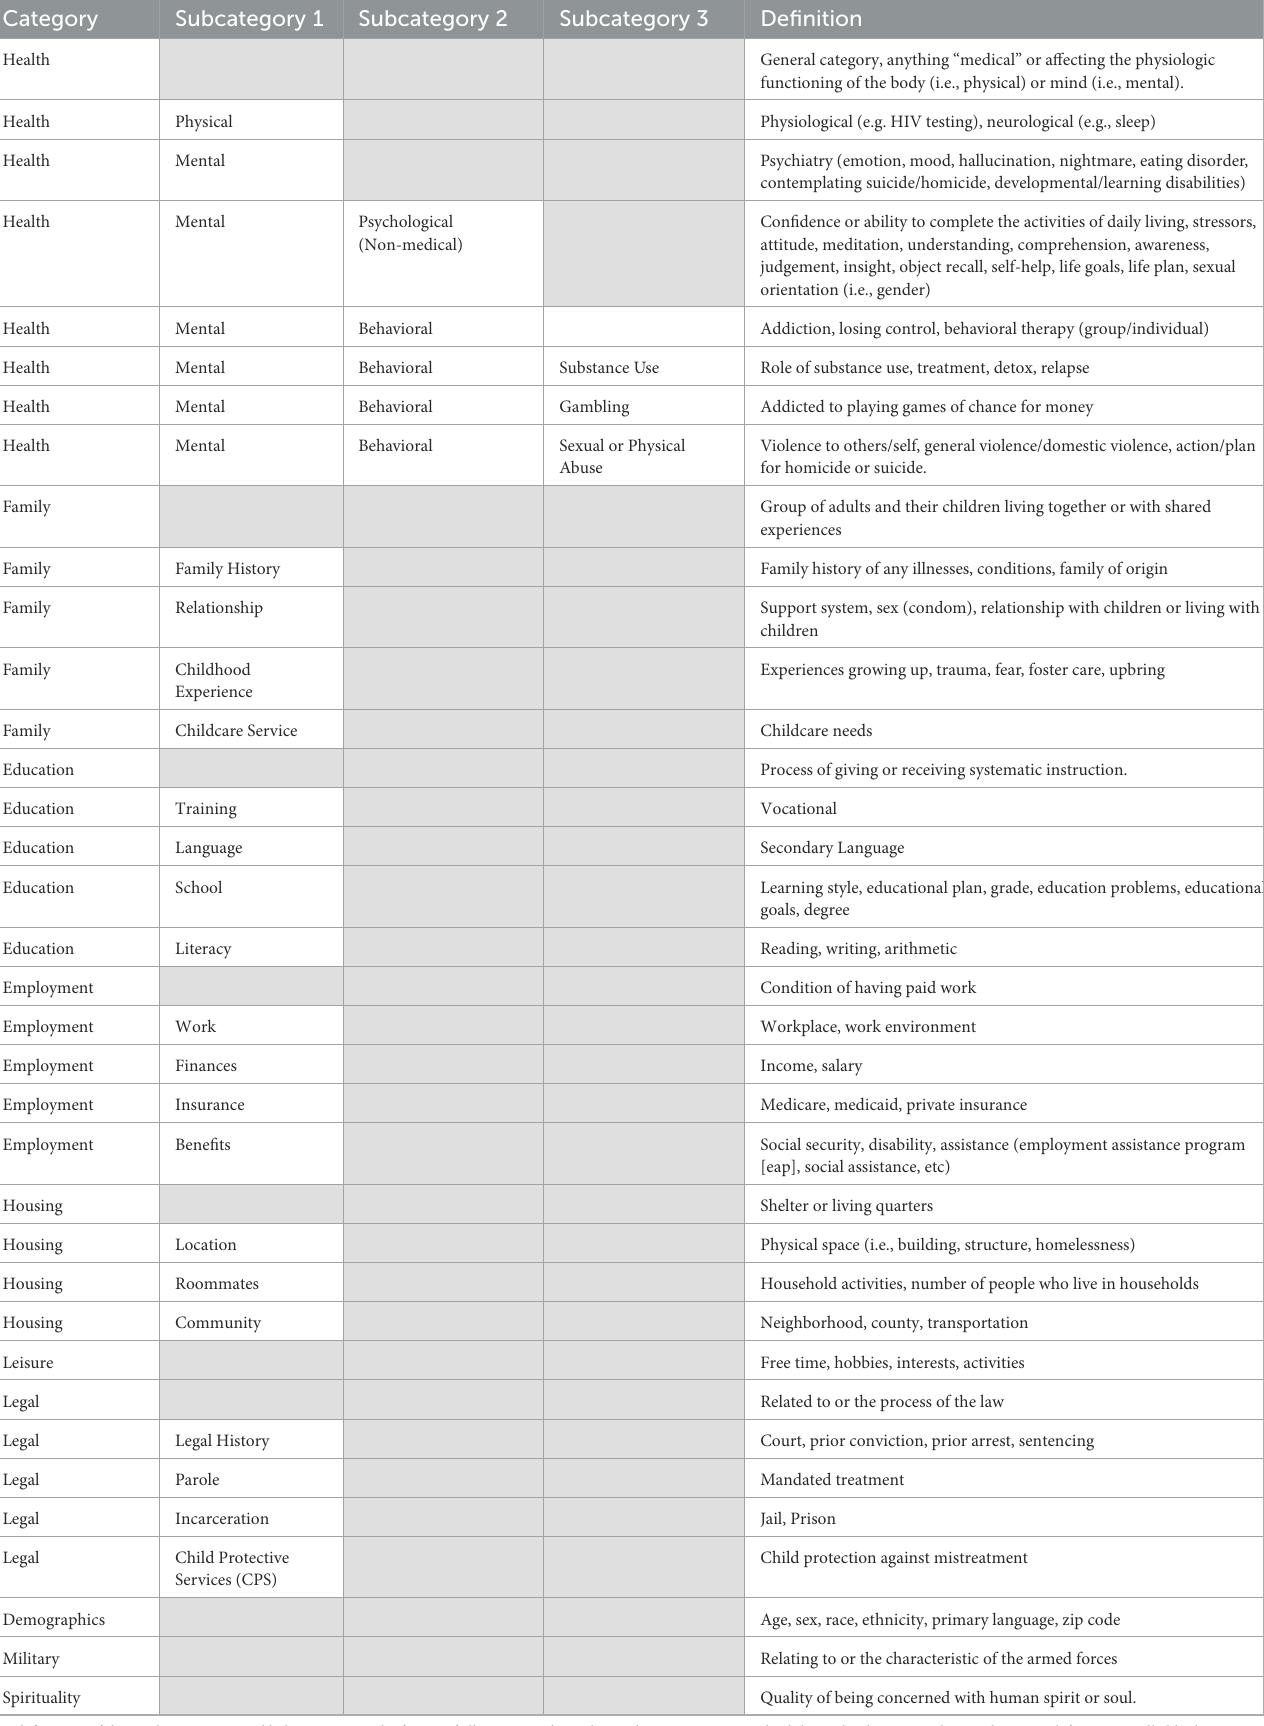
TABLE 4 Final clustering table.